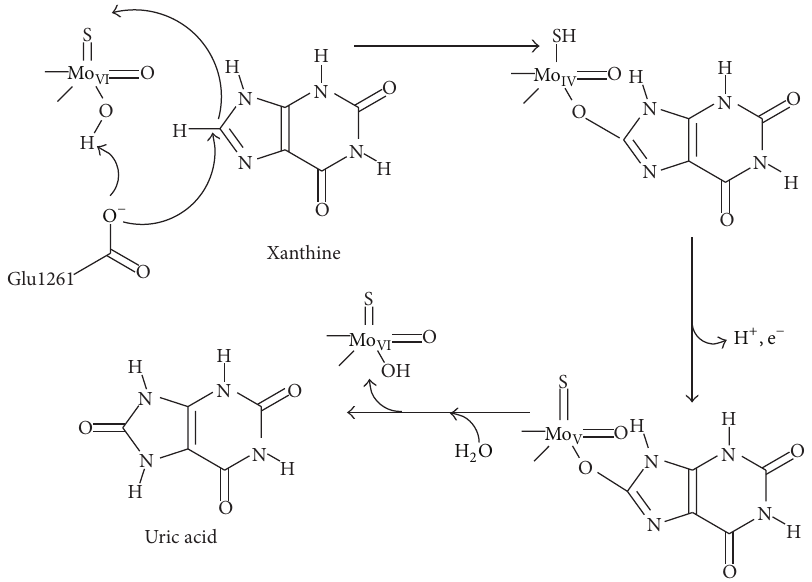
Scheme 1: Transformation of xanthine to uric acid by XO.